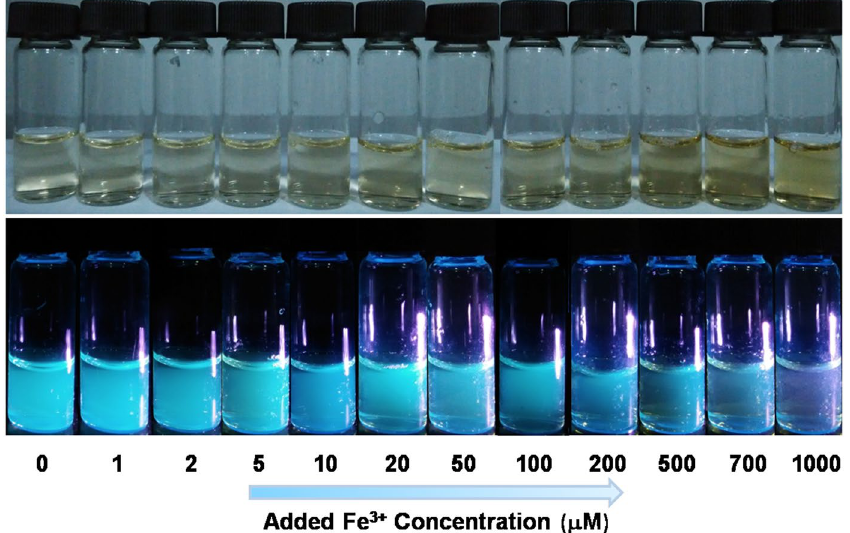
Figure 7. Photographs of as-prepared CNDs suspension upon addition of Fe 3 + with different concentrations ranging from 0–1000 μ M under under daylight (above) and upon irradiation with 365 nm UV light